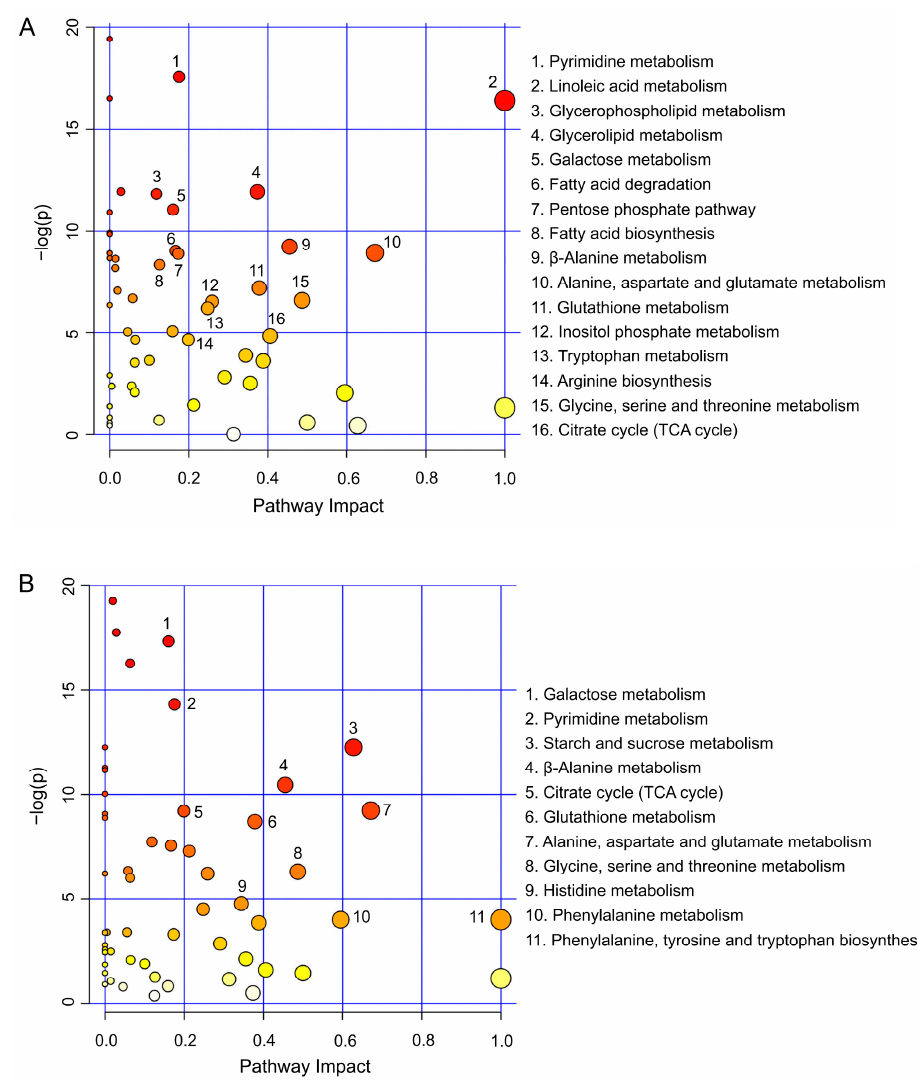
Figure 6. Enrichment of metabolic pathways in A549 cells treated with ( A ) PQ and ( B ) Del. The larger circle and darker color represented the greater impact on metabolic pathways. The X axis represents the impact factor of the pathway topology analysis and the Y axis represents the p value of the pathway enrichment analysis.